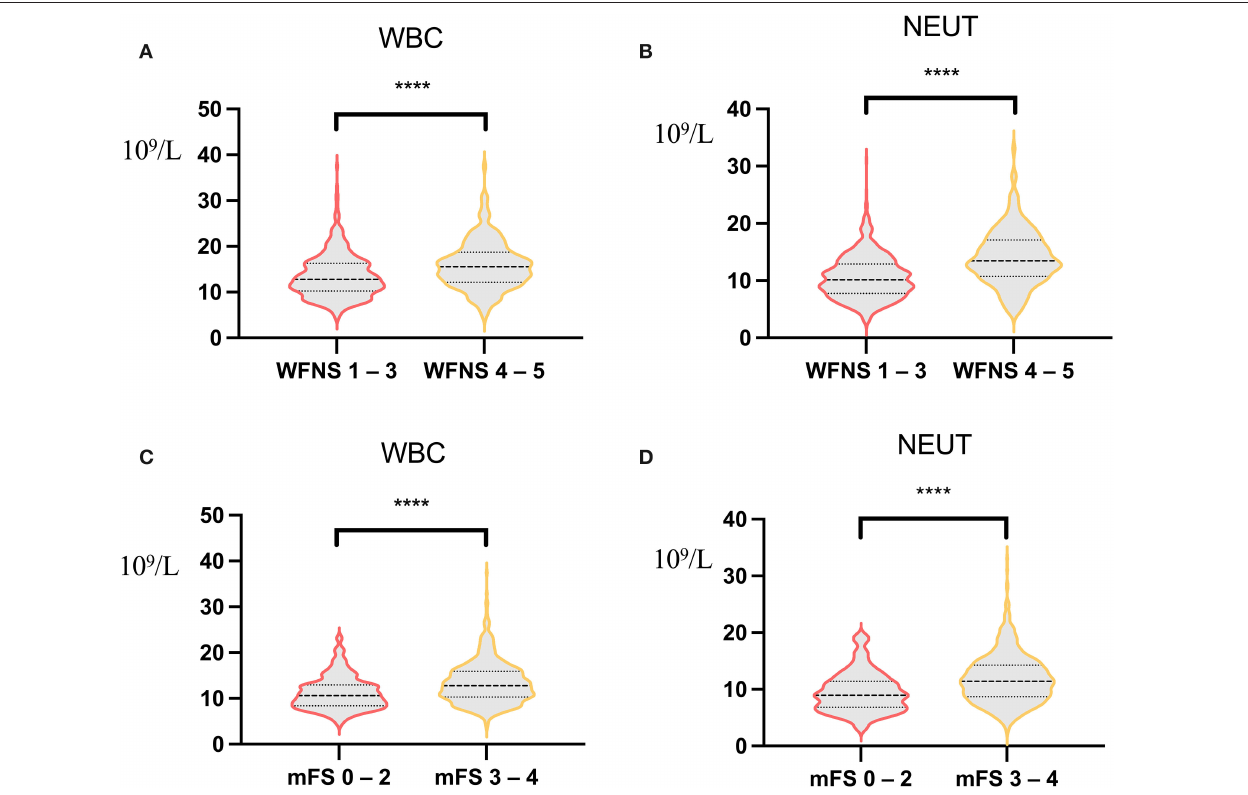
FIGURE 4 | Correlation analysis of World Federation of Neurosurgical Societies (WFNS) score, modified Fisher Scale (mFS) score, and inflammatory indicators. (A) Correlation analysis of white blood count (WBC) between WFNS grade 1–3 and WFNS grade 4–5 [12.14 (3.88) vs. 15.88 (5.19), p < 0.001]. (B) Correlation analysis of neutrophil between WFNS grade 1–3 and WFNS grade 4–5 [10.59 (3.78) vs. 14.03 (4.82), p < 0.001]. (C) Correlation analysis of WBC between mFS grade 0–2 and mFS grade 3–4 [11.18 (3.59) vs. 13.44 (4.57), p < 0.001]. (D) Correlation analysis of neutrophil between mFS grade 0–2 and mFS grade 3–4 [9.50 (3.52) vs. 11.85 (4.31), p < 0.001). **** p <